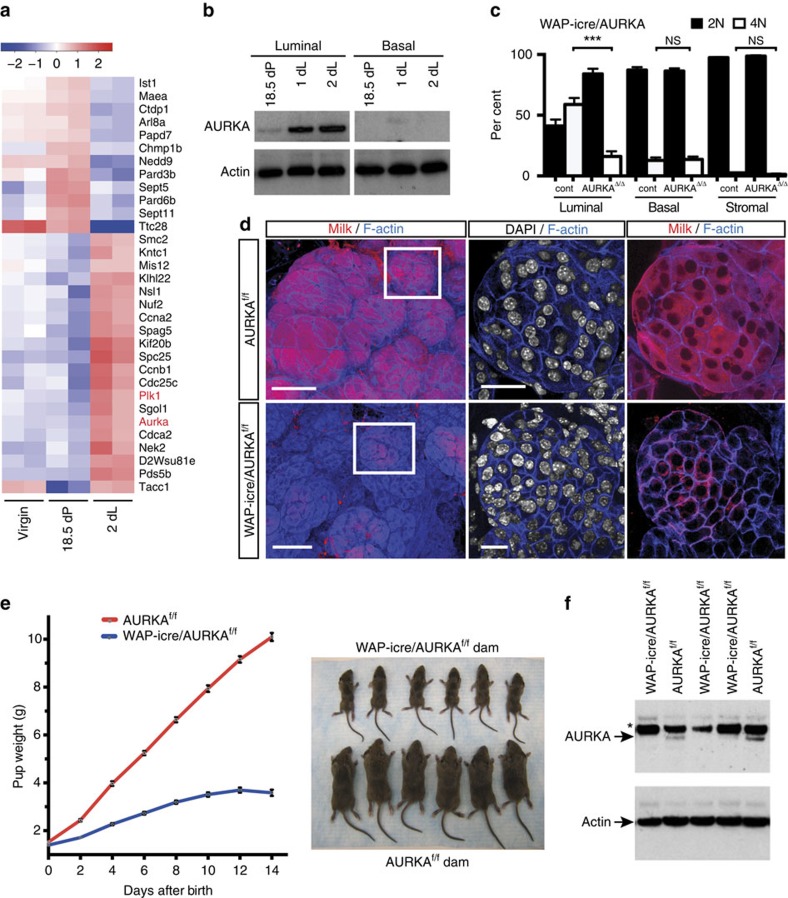
AURKA is induced at the onset of lactation and is essential for the formation of binucleated cells.(a) Heat map showing genes differentially expressed between the virgin state, late pregnancy and early lactation in sorted luminal cells for the cell division GO group. AURKA and PLK1 are marked in red; P<0.05 for 2 dL versus 18.5 dP (using a TREAT-moderated t-test). (b) Representative western blot analysis (n=2) of AURKA expression in sorted luminal (Lin−CD29loCD24+) and basal (Lin−CD29hiCD24+) cells isolated from pregnant (18.5 dP) or lactating glands (1 and 2 dL). (c) Bar graph of FACS data showing percentage of cells containing 2N or 4N DNA content in the luminal, basal and stromal cell compartments from WAP-icre/AURKAf/f (AURKAΔ/Δ) and control AURKAf/f mice at 2 dL. Error bars represent mean±s.e.m. (n=3 mice) ***P<0.001. (d) Representative whole-mount 3D confocal images of ductal portions and optical sections from the enlarged region for WAP-icre/AURKAf/f glands (bottom) compared with control AURKAf/f mammary glands (top). The whole-mounts were labelled for DAPI (white), milk (red) and F-actin (blue). Scale bars: 100 μm (whole-mounts); and 20 μm (optical sections). (e) Body weight of pups nursed by WAP-icre/AURKAf/f dams versus littermate control AURKAf/f dams (n=6). Error bars represent mean±s.e.m. P<0.0001. Representative photograph of pups nursed by a WAP-icre/AURKAf/f dam versus an AURKAf/f dam at 14 dL. (f) Western blot analysis (n=2) of expression of AURKA and Actin in WAP-icre/AURKAf/f compared with AURKAf/f glands at 2 dL. The asterix denotes a nonspecific band.